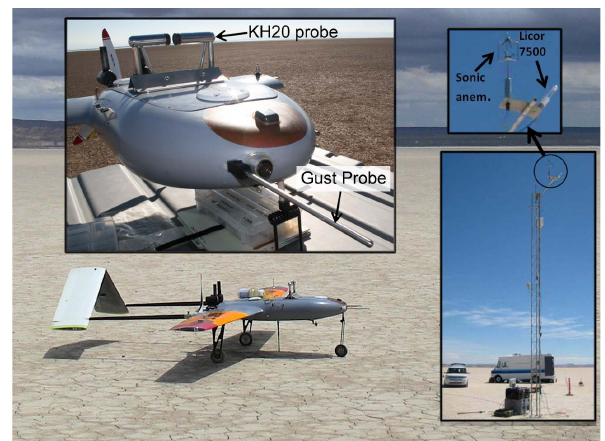
Fig. 1. Image of the manta UAV on Roger’s lake bed in prepara- tion for afternoon take off on the 27th May 2010. Also shown are the water vapor flux instruments on the Manta (inset left) and the surface tower (inset